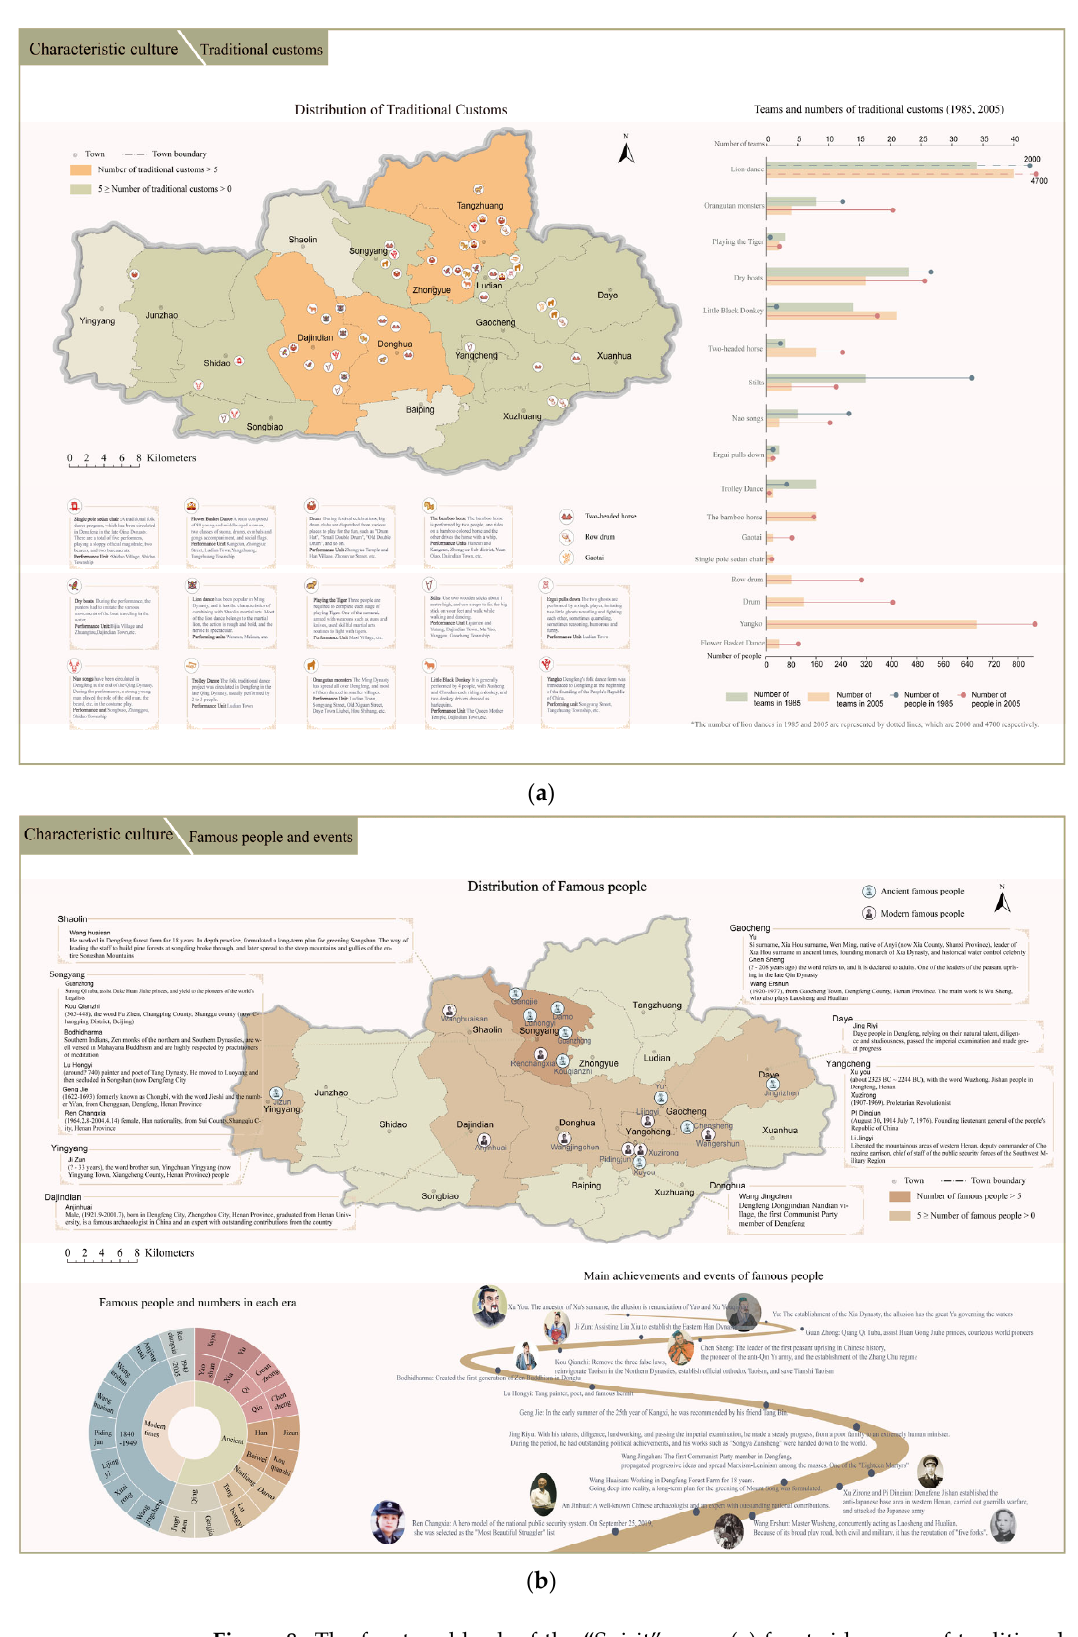
Figure 8. The front and back of the “Spirit” map: ( a ) front side: map of traditional customs; ( b ) backside: map of famous people and events.